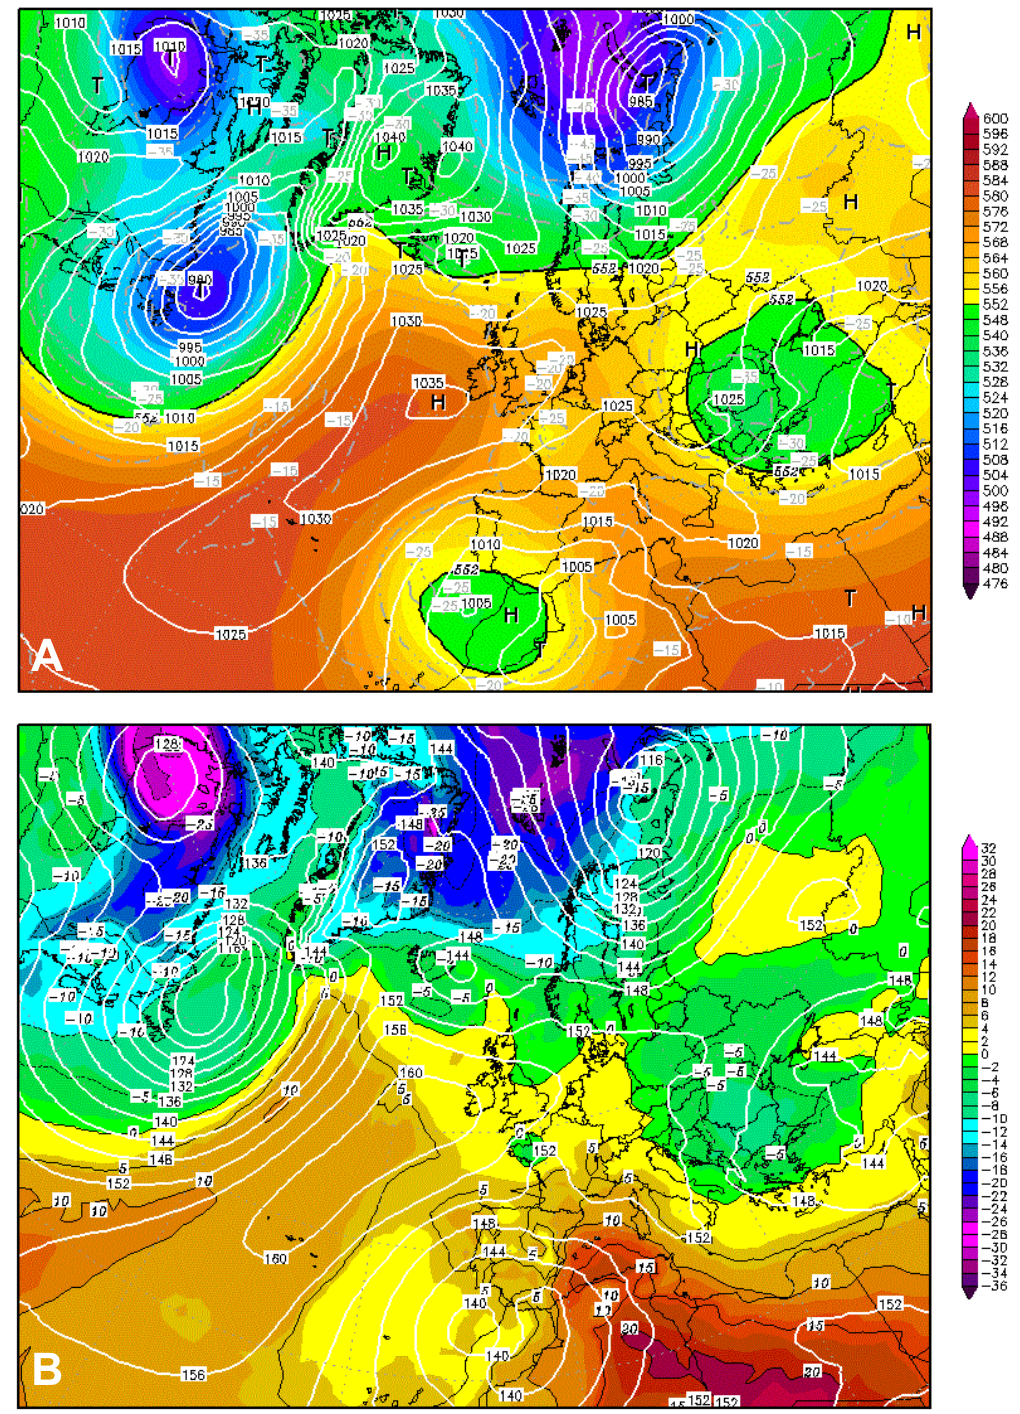
Figure 3. (A) 500 hPa geopotential (gpdm), temperature (°C) and sea-level pressure (hPa), and (B) 850 geopotential (gpdm) and tempera- ture (°C) in Europe on March 20, 2015. Figure from